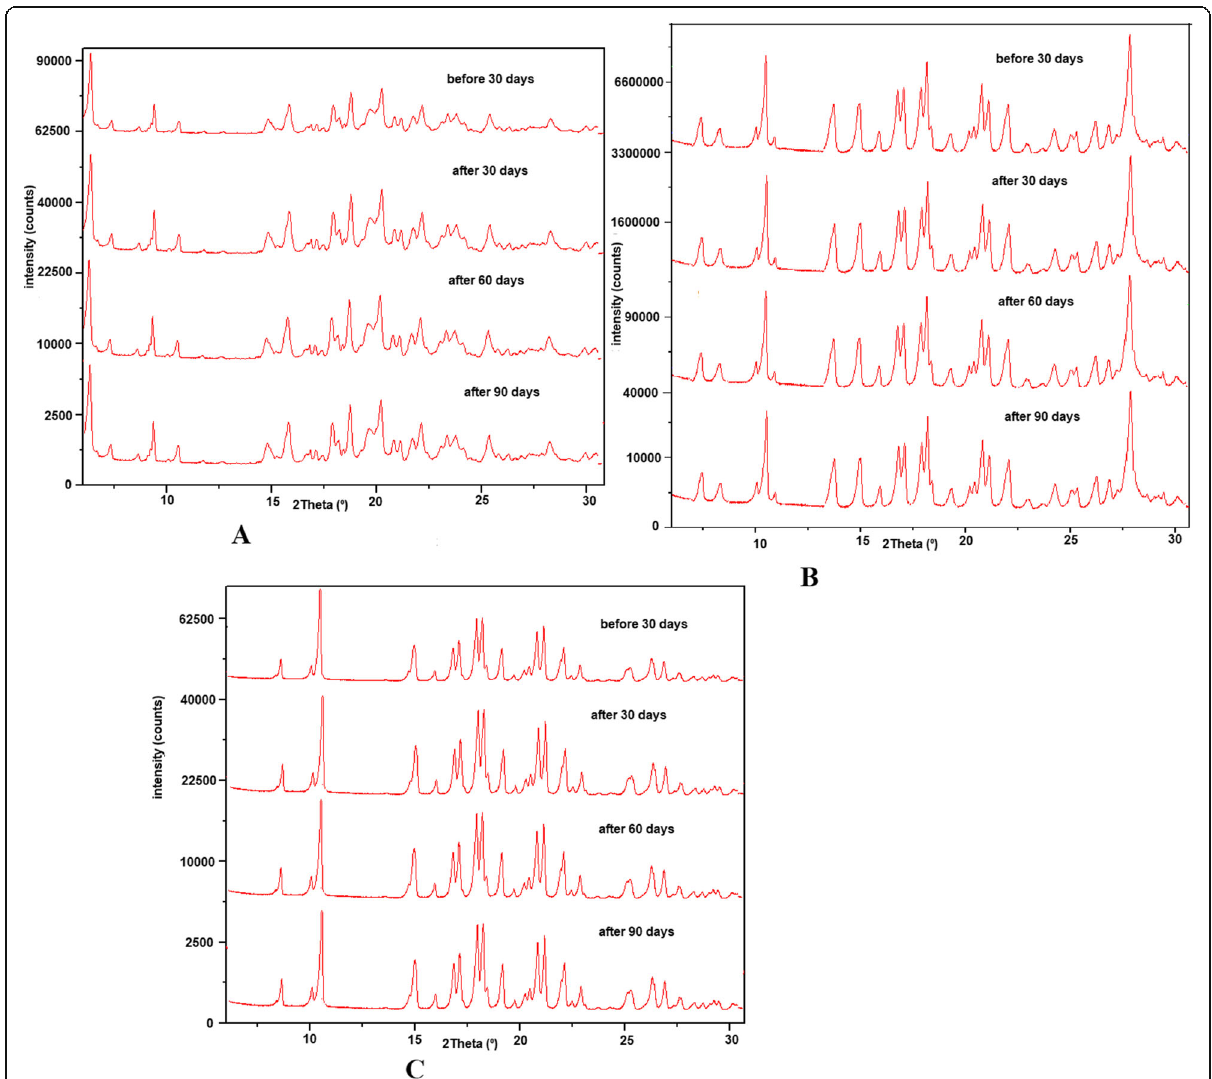
Fig. 6 Stability studies of A GLZ-DNS, B GLZ – PDA, and C GLZ – LPN cocrystals